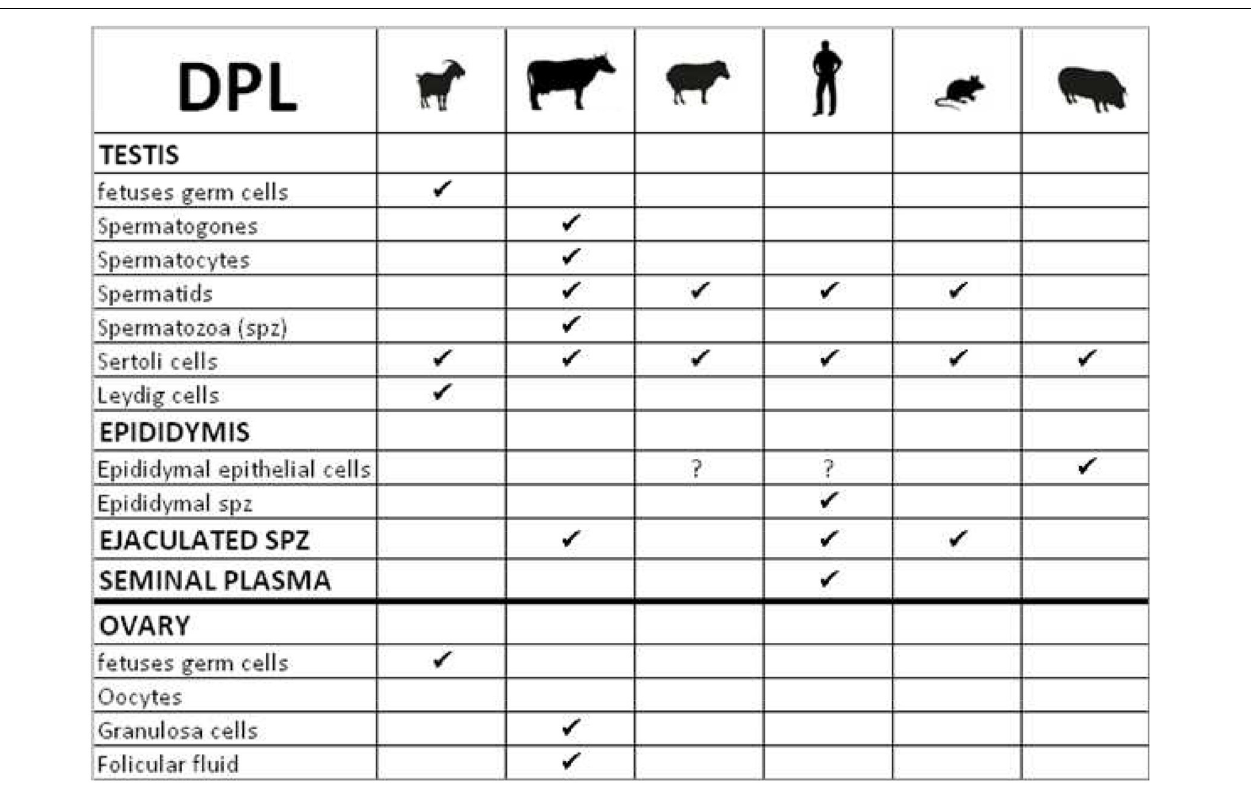
FIGURE 5 | Table summarizing the cellular localization of Dopple (DPL) in gonads of various species.